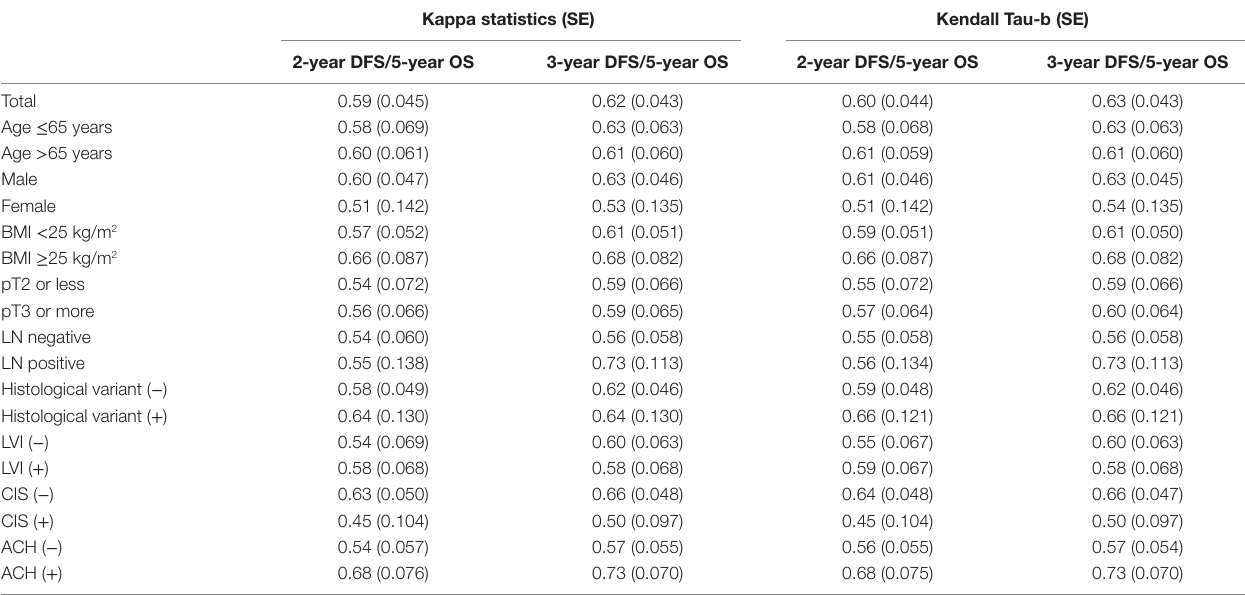
TaBle 2 | The Kappa statistic and Kendall tau-b test for the dependence between disease-free survival and overall